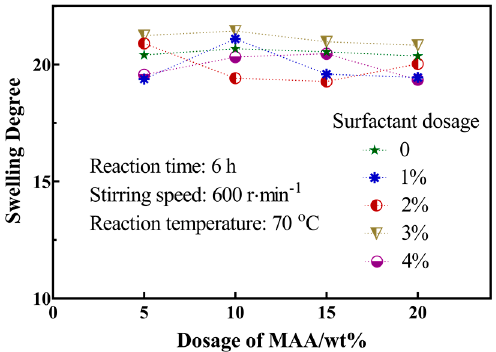
ff ect of reaction parameters on the swelling ratio of the hollow Figure 5. Effect of reaction parameters on the swelling ratio of the hollow microspheres. Figure 5. E